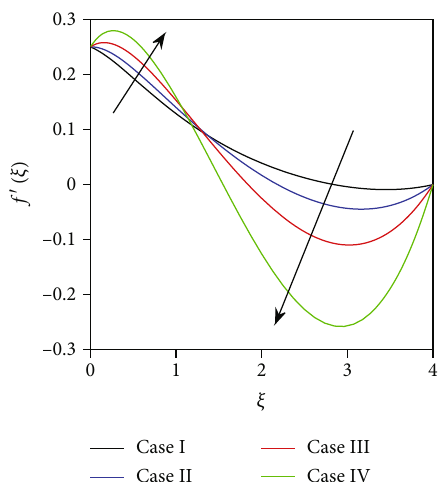
Figure 11: Microrotation ψ ð ξ Þ pro fi les for micropolar material constants A 1 – A 6 .